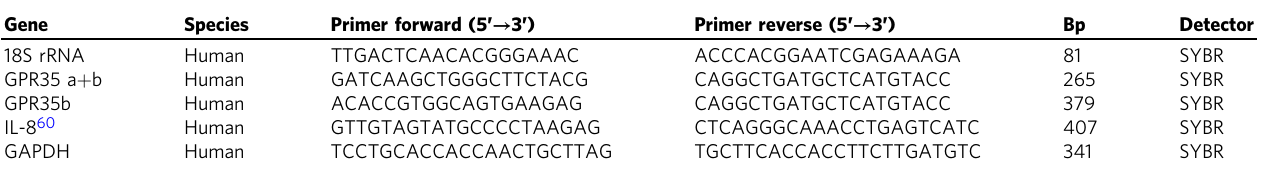
Table 2 Primer combination for SYBR green qPCR.